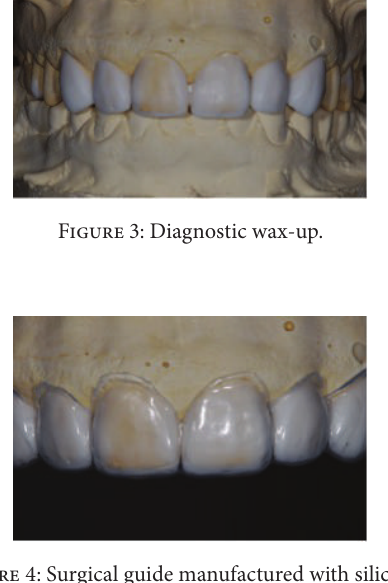
Figure 2: Preoperative intraoral view.